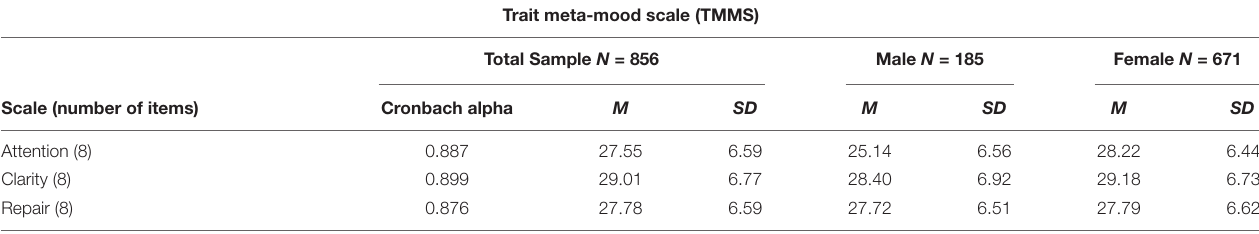
TABLE 1 | Cronbach’s alphas, means, and standard deviations of the variables examined.